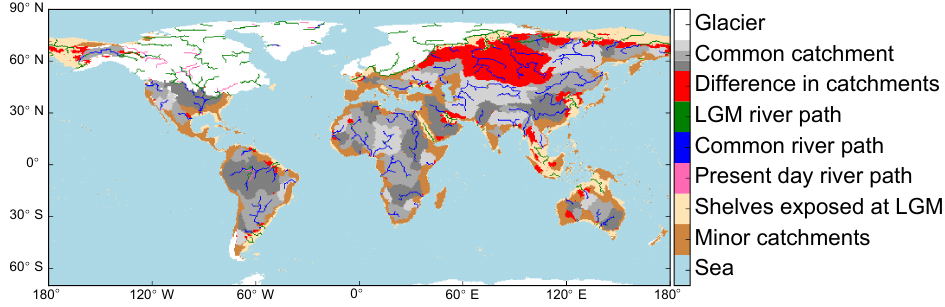
Figure 7. Comparison of the most significant rivers at the LGM and present day generated by the method described in this paper using the ICE-6G_C reconstructed orography for the LGM. Rivers are shown where the cumulative flow to a given grid cell (on the HD grid) is greater than or equal to 100 cells. The various colours show various rivers that existed only at the LGM (green), only at the present day (pink) or at both (blue). The catchments of major rivers are marked. Differences between the catchments are shown in red; areas of catchments that are common between both time slices are marked in grey. The three different shades of grey are used to pick out individual river catchments; no significance is attached to the shade chosen for each river. Continental shelves which were exposed as dry land at the LGM by the significantly lower sea level are also marked. Rivers shown on the surface of ice sheets are topographically defined rivers, and thus their presence does not necessarily imply that there were rivers running off the northern slopes of the Laurentide and Fennoscandian ice